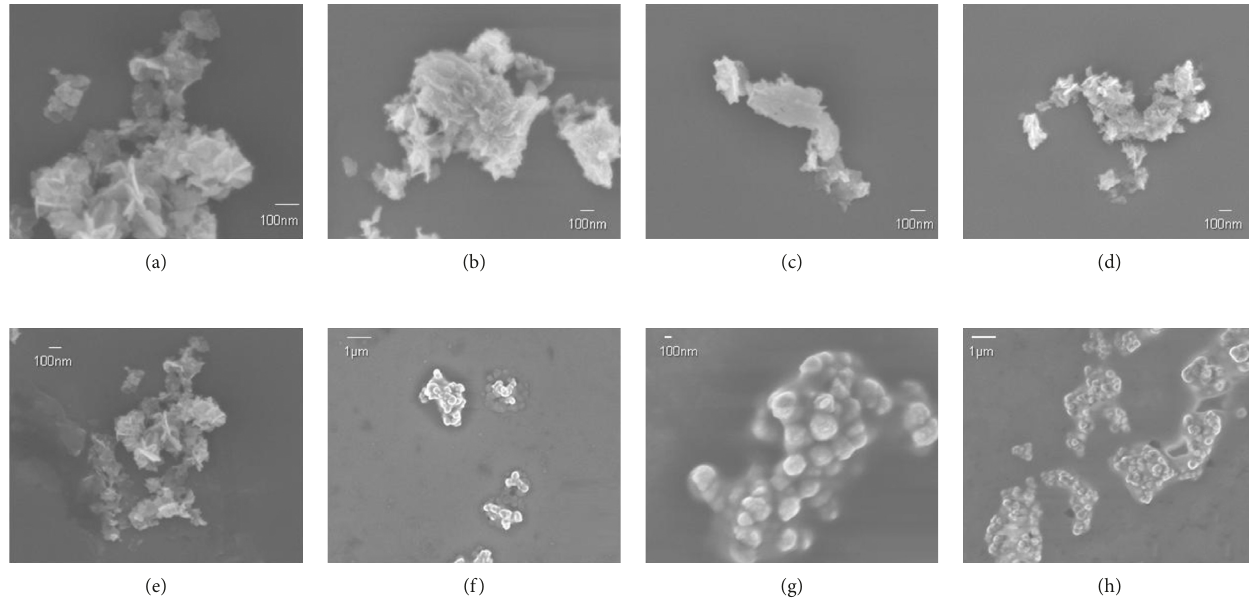
Figure 1: SEM images of morphology and sizes of prepared particles, (a) and (e) correspond to samples with 0.324g of PVP; (b), (c), and (d) correspond to samples with 0.640g of PVP, and (f), (g), and (h) correspond to samples with 0.964g of PVP.